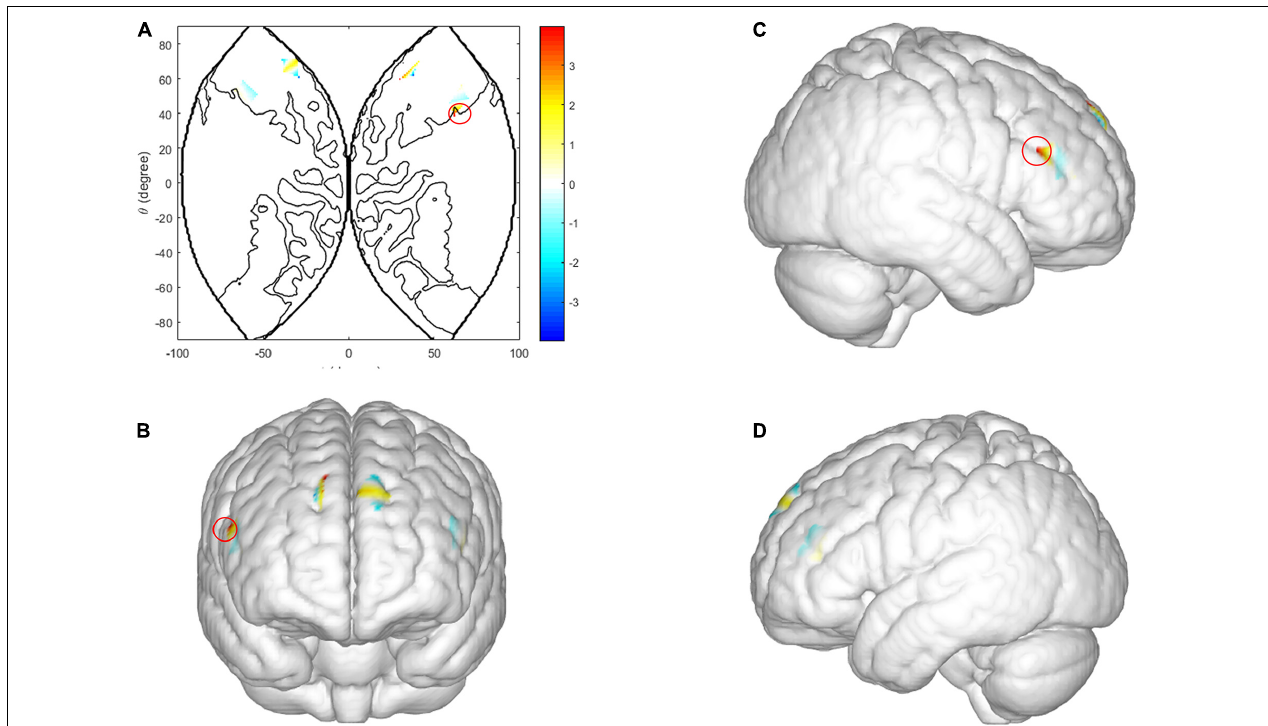
FIGURE 5 | Inter brain synchronization in ISDM stage. (A–D) Higher INS values in the right IFG (female dyads vs. male dyads). (A) The 2D model of INS values of the right IFG; (B) front, (C) right, and (D) left view of a 3D model of INS values of the right IFG.